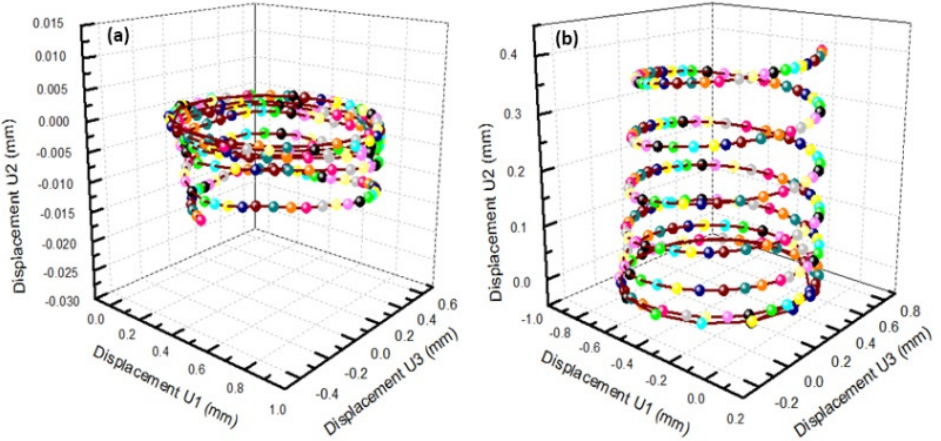
Figure 9. The spatial motion trajectories: ( a ) P11; ( b ) P12.